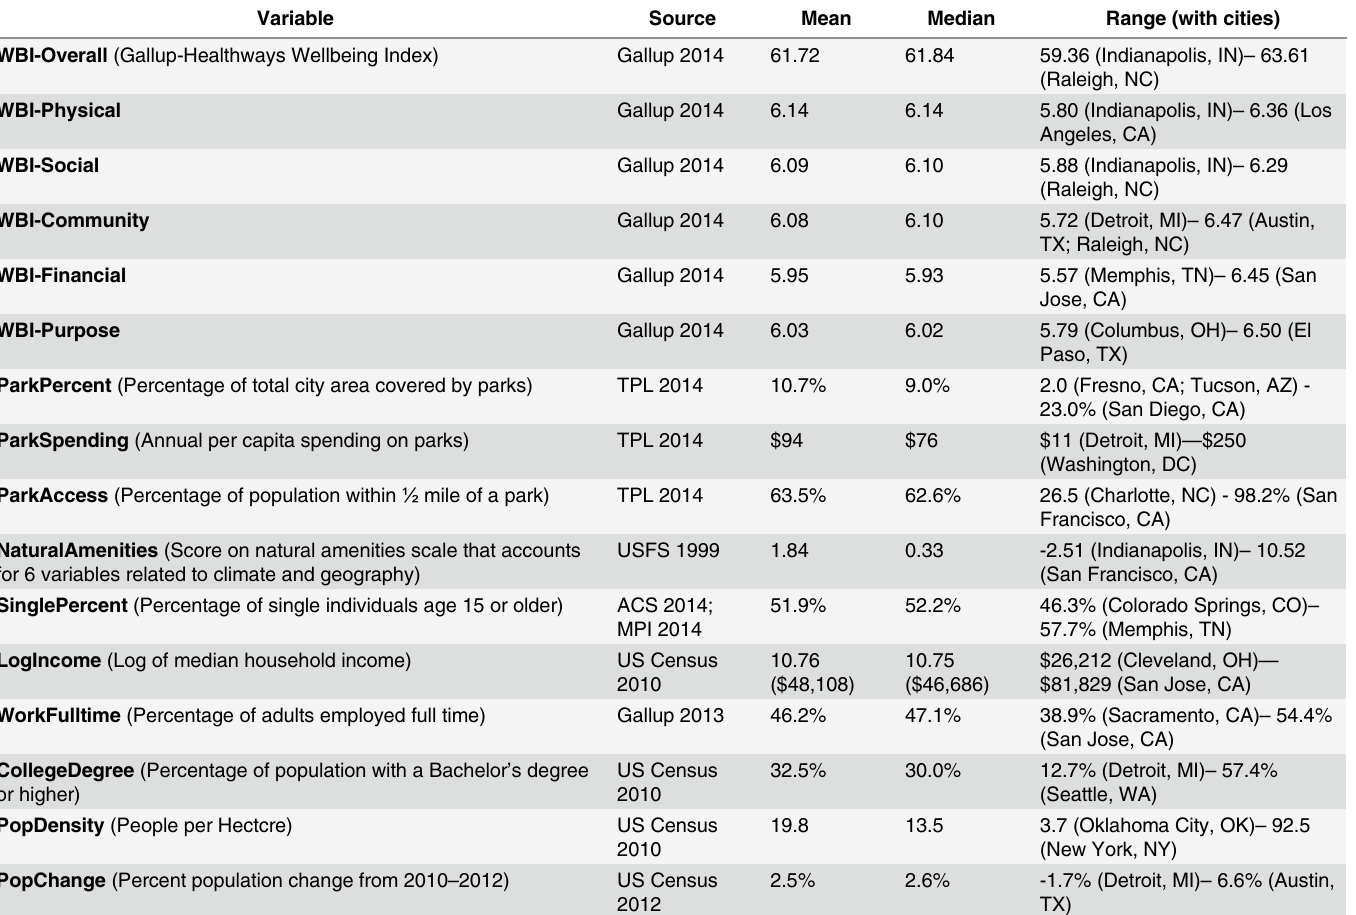
Table 1. Variables Used in the Linear Regression Model Examining Factors Associated with Wellbeing in U.S.